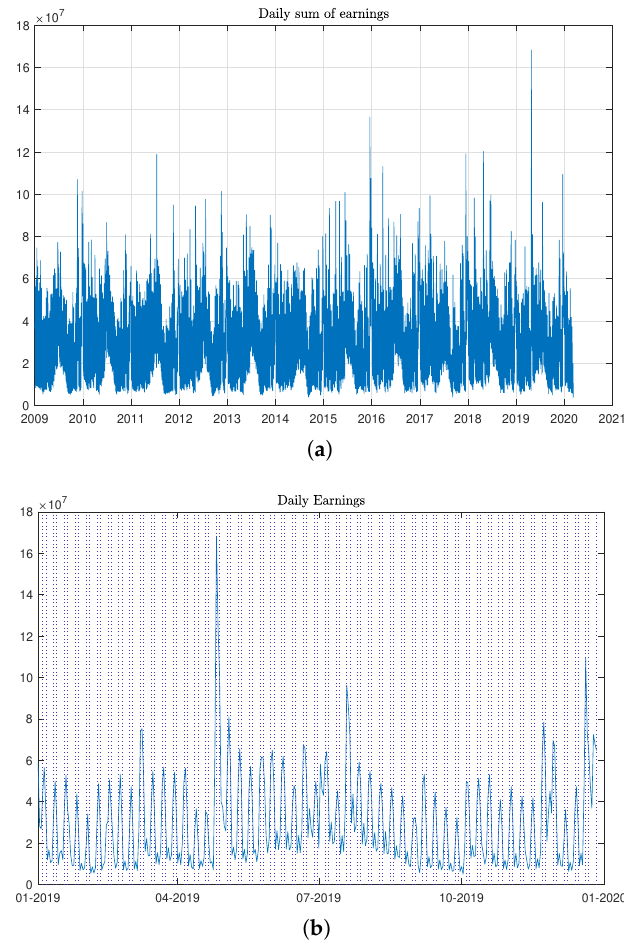
Figure 7. Aggregate daily box-office earnings series y t . In panel ( a ) the series is plotted over the whole horizon 2009–2020, whereas in panel ( b ) only 2019 data are considered. It is easy to observe the weekly seasonality with weekend upward spikes. The unusually high spike in 2019 just before the regular summer season was due to the April 26 release of Avengers: Endgame